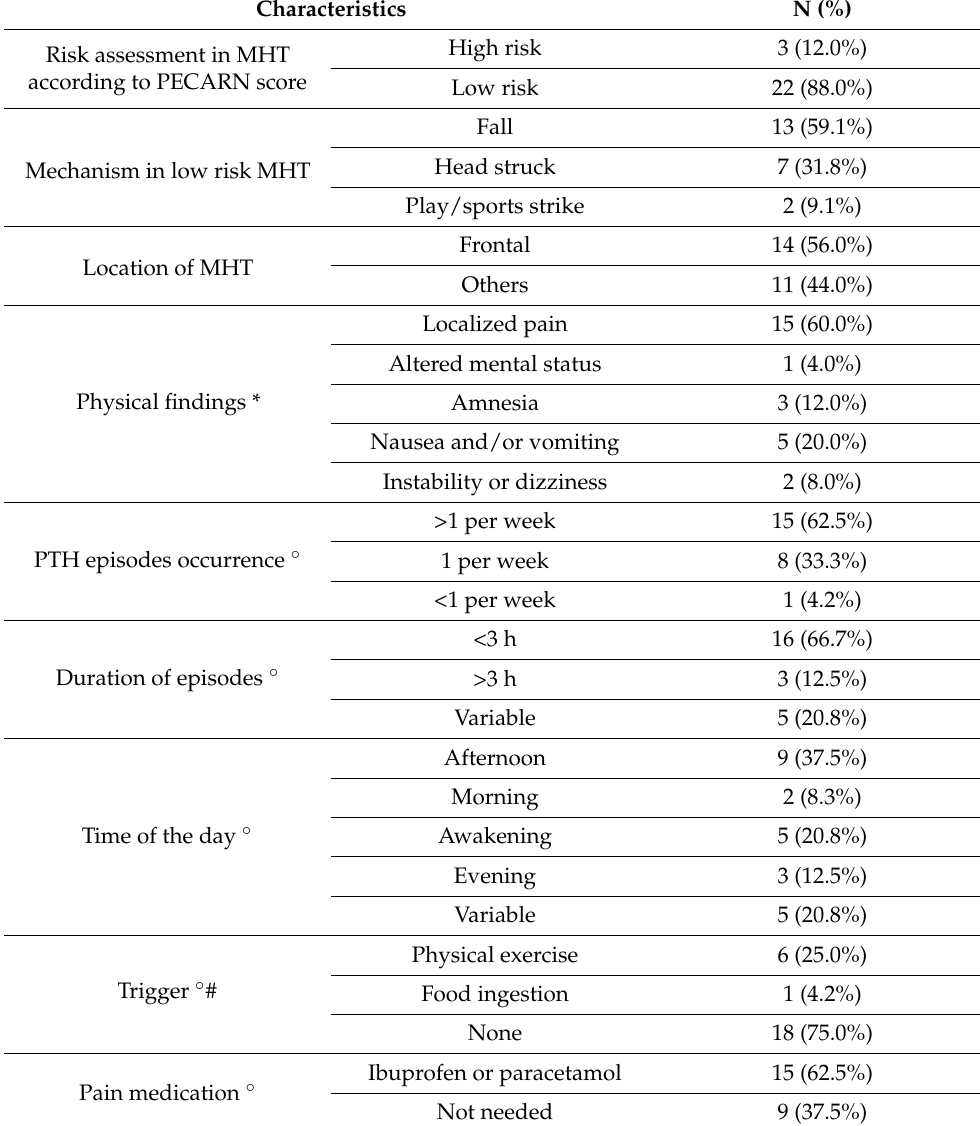
Table 2. Characteristics of 25 patients referred to the pediatric emergency department (PED) for minor head trauma (MHT) and who developed post-traumatic headache (PTH). PECARN: Pediatric Emergency Care Applied Research Network. * Some patients presented multiple physical findings; ◦ 1 patient was lost at follow up; # 1 patient experienced multiple